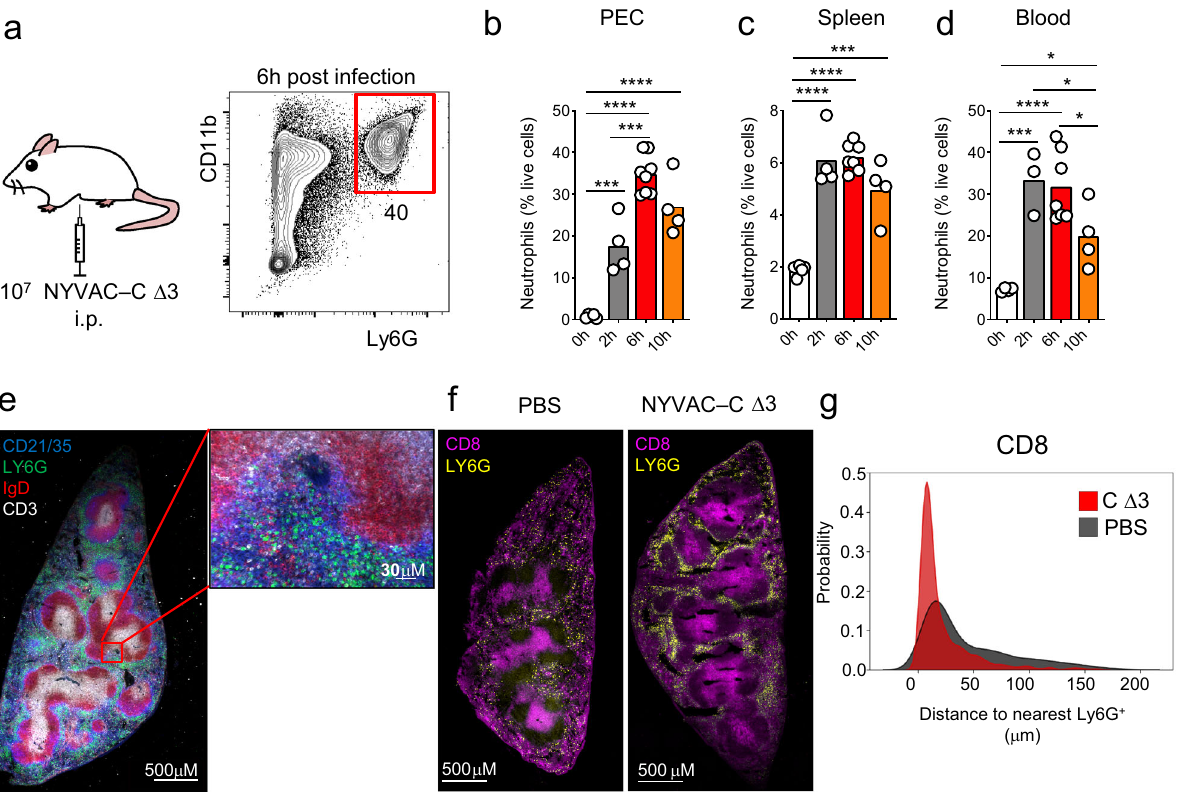
Fig. 1 In vivo time-course of neutrophil accumulation after poxvirus infection. BALB/c mice were infected by intraperitoneal (i.p.) injection of 10 7 PFU of NYVAC-C Δ 3 virus and Ly6G + CD11b + neutrophils were measured at 6 h post infection ( a ). Percentages of neutrophils in peritoneal cavity (PEC) ( b ), spleen ( c ), and blood ( d ) at 0, 2, 6, and 10 h post infection from NYVAC-C Δ 3 injected mice. Spleen tissue section and its magni fi cation from NYVAC-C Δ 3-infected mice. Ly6G + neutrophils in green, CD3 + T cells in white, IgD + B cells in red, and CD21/35 + cells in blue ( e ). Spleen tissue section from PBS and NYVAC-C Δ 3-injected mice. Ly6G + neutrophils in yellow, CD8 + T cells in purple ( f ). Distance of the nearest Ly6G + cell from CD8 + cells. The nearest neighbor euclidean distance to Ly6G + is expressed as probability density for each cell belonging to CD8 + clusters ( g ). Graphs show mean; each point represents an individual mouse. Data are representative of two independent experiments. * P < 0.05, *** P < 0.001, **** P <